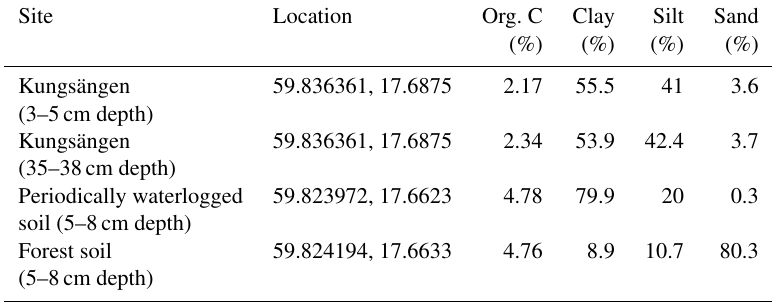
Table 1. Location of each sampling site, organic carbon (Org. C), clay, silt and sand contents. Site